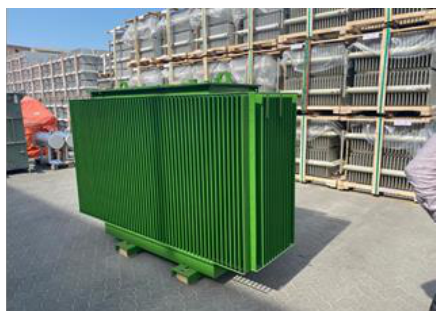
Figure 8. Relative small size 2300 kVA ester-immersed transformer with KNAN cooling system.